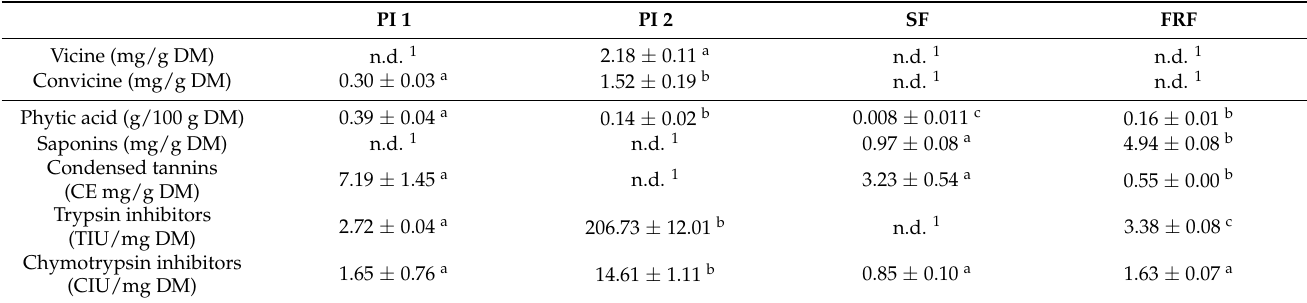
Table 2. Antinutritional factors of the faba bean fractions, means ± standard